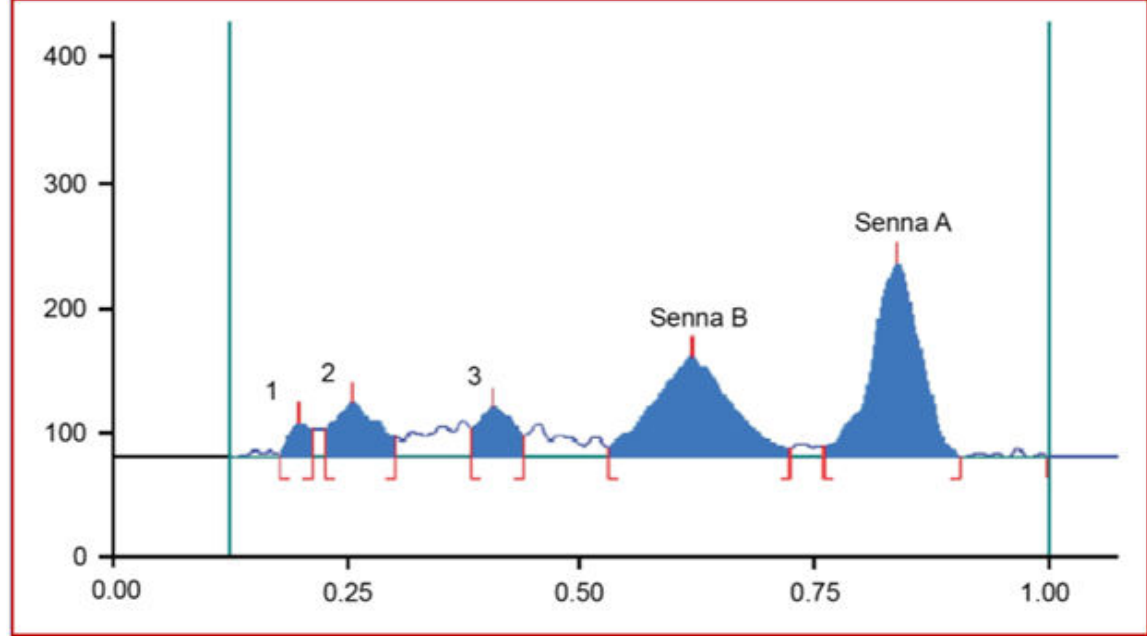
Figure 1: TLC plate showing the distinct separation of sennoside A and B after development in Twin Trough chamber